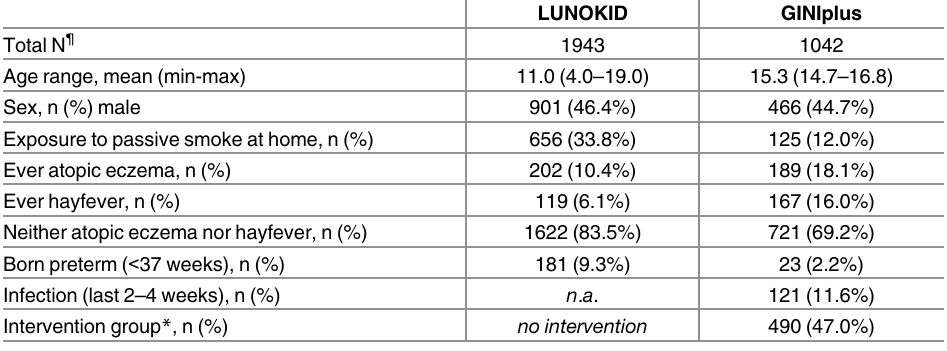
Table 2. Description of the lung healthy study populations (LUNOKID and GINIplus). Further exclusion criteria for sensitivity analyses.